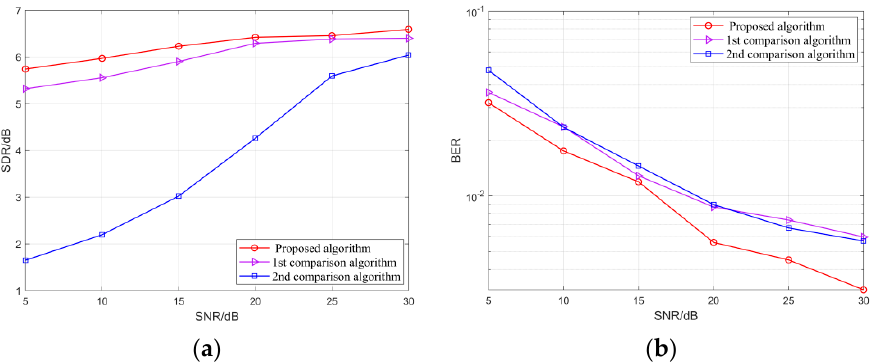
Figure 16. ( a ) The SDR of different modulation signals under different SNR; ( b ) The BER of differ-